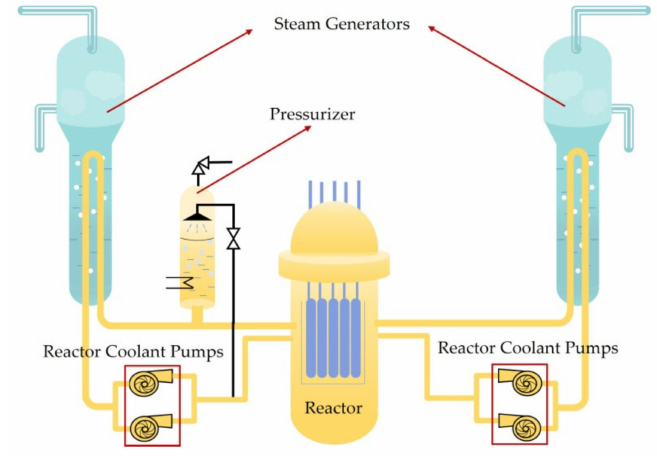
Figure 3. Reactor coolant system.